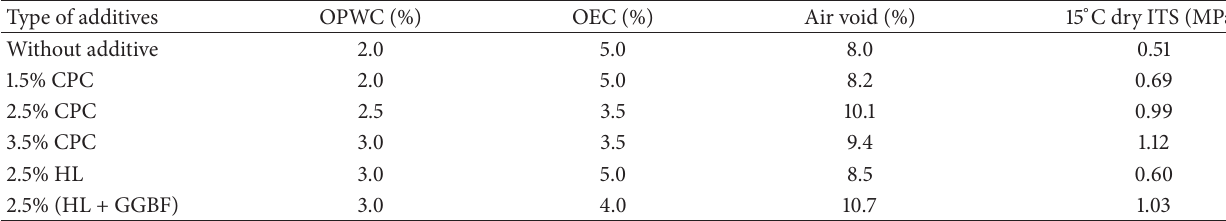
Table 4: Mix design results of asphalt emulsion recycled mixtures.